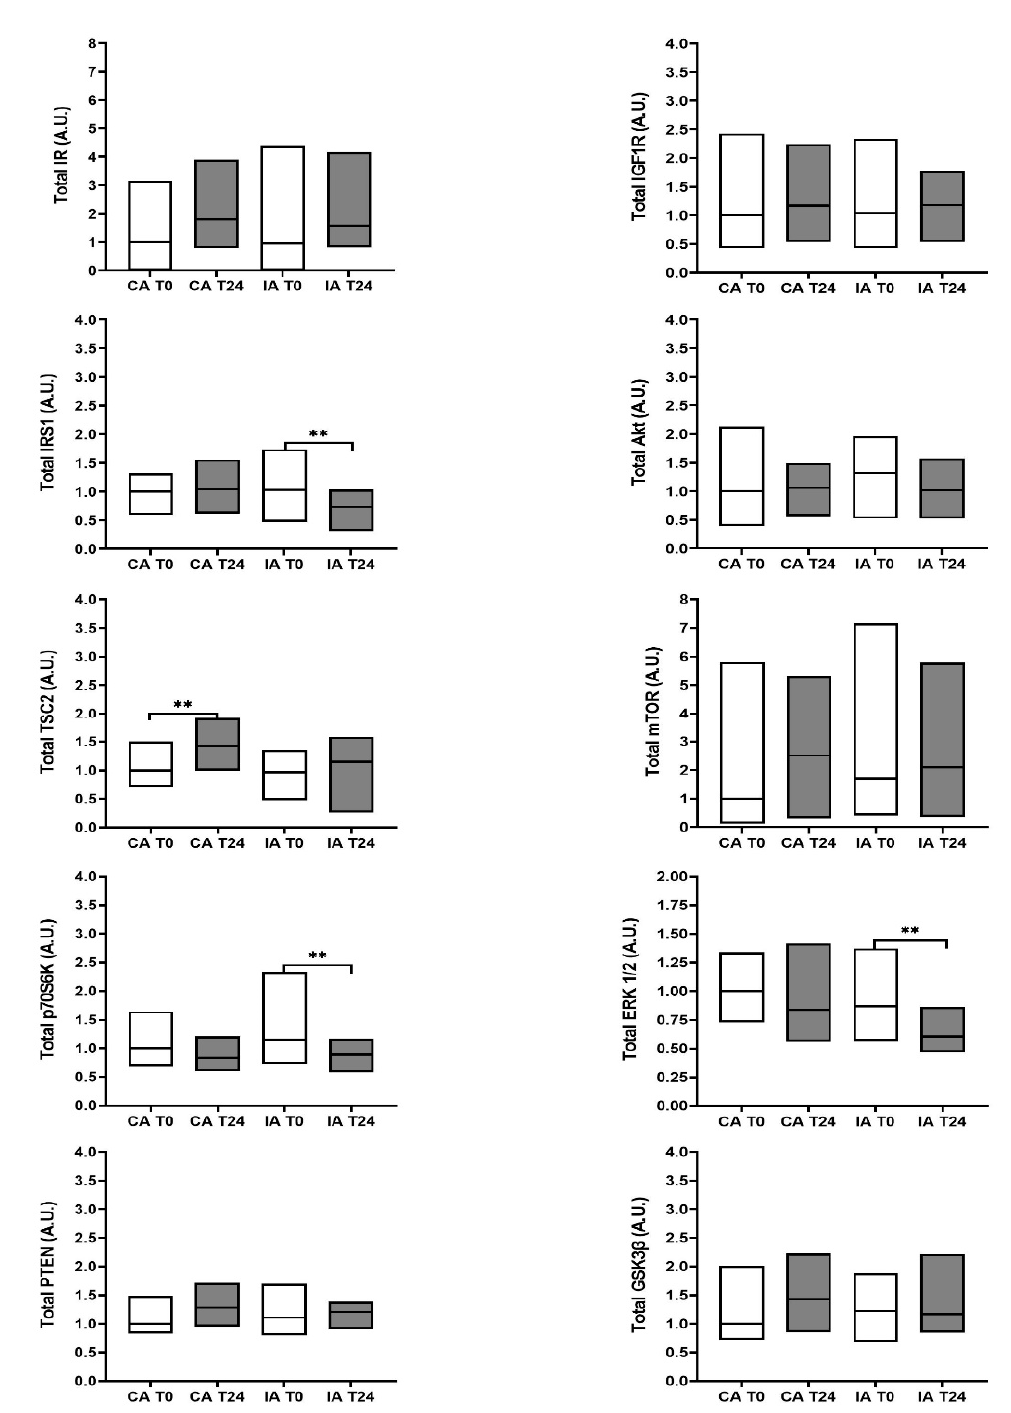
Figure 3. Total protein expression involved in insulin/IGF-1 signal transduction in esophageal tissue affected by Barrett’s esophagus. Protein expression was analyzed at baseline (T0, white boxes) and 24 months later (T24, black boxes) in both the control arm (CA) and intervention arm (IA). Data are expressed as the median (Q1; Q3) related to an arbitrary unit (A.U.), defined as described in the Materials and Methods Section. The Wilcoxon matched-pairs signed-rank test was used to compare measurements at T0 and T24 within the same group. The Mann–Whitney U test was performed to evaluate differences between the CA and IA at baseline. ** p < 0.01.